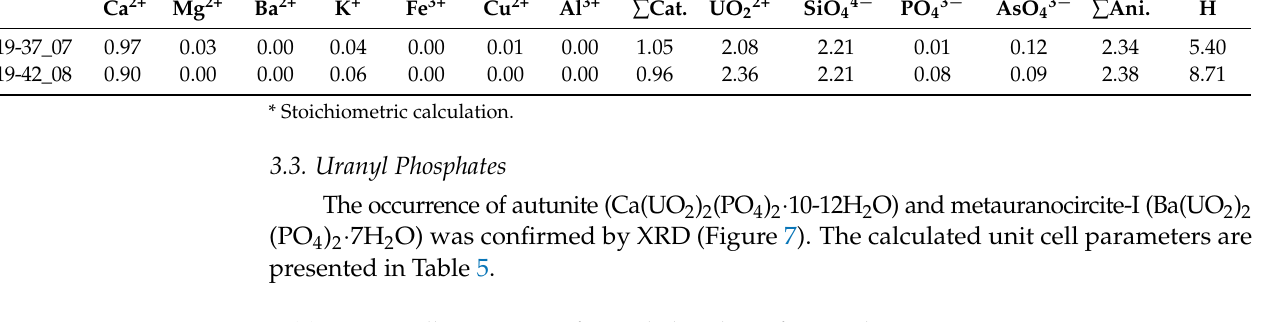
Table 5. Unit cell parameters of uranyl phosphates from Podg ó rze